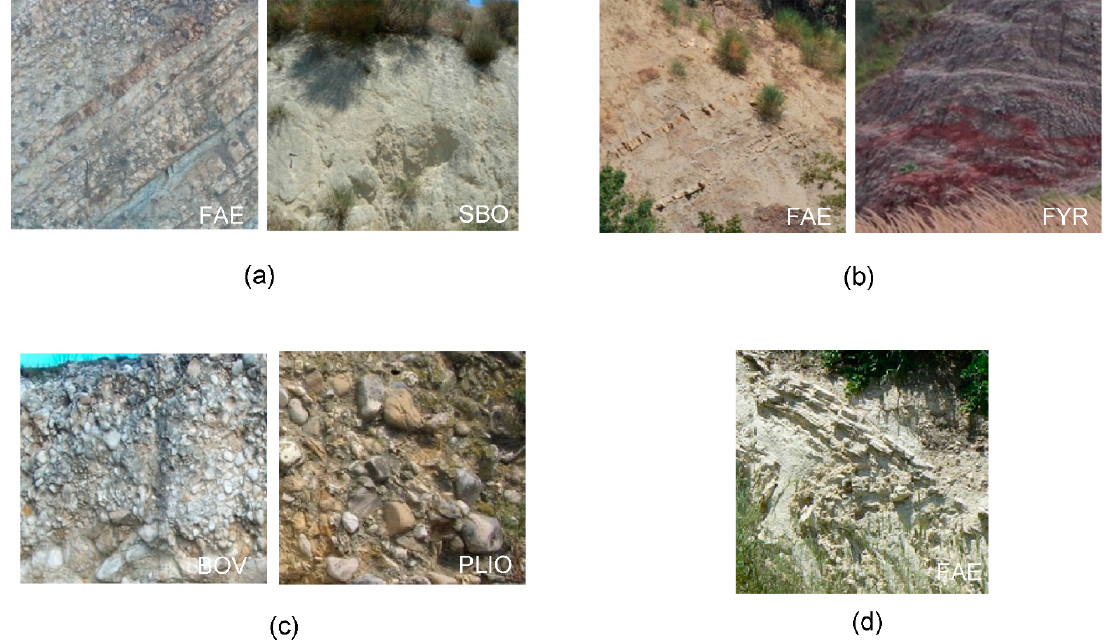
Figure 4. ( a ) Rocky; ( b ) clayey; ( c ) conglomeratic units (FAE—Faeto Flysch, SBO—San Bartolomeo Flysch, FYR—Red Flysch, BOV—Bovino Synthem, PLIO—Pliocene Conglomerate); ( d ) transitional rocky–clayey FAE unit with fractured rock layers.